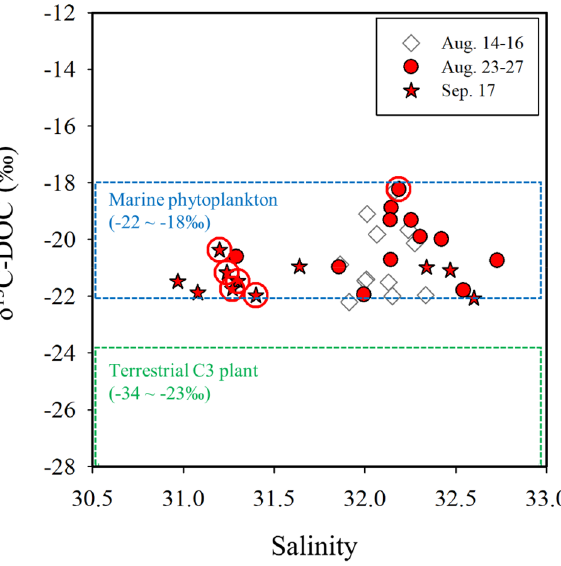
Figure 4. A Plot between δ 13 C-DOC values and salinities in seawaters from the Tongyeong coast during August 14–16, August 23–27, and September 17, 2019. The red circles represent the centers of the red tide patches. The blue dashed box indicates the range of δ 13 C-DOC values of marine phytoplankton-derived DOC, and the green dashed box indicates the range of δ 13 C-DOC values of terrestrial C 3 plant-derived DOC according to Gearing 24 and Fry et al. 73